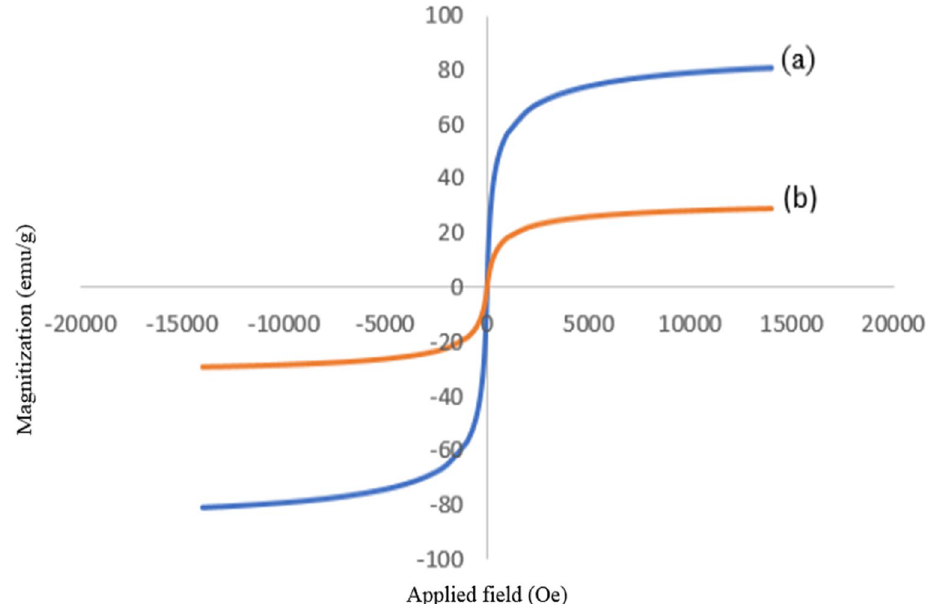
Fig. 3 Magnetization curves of (a) bare Fe 3 O 4 and (b) Fe 3 O 4